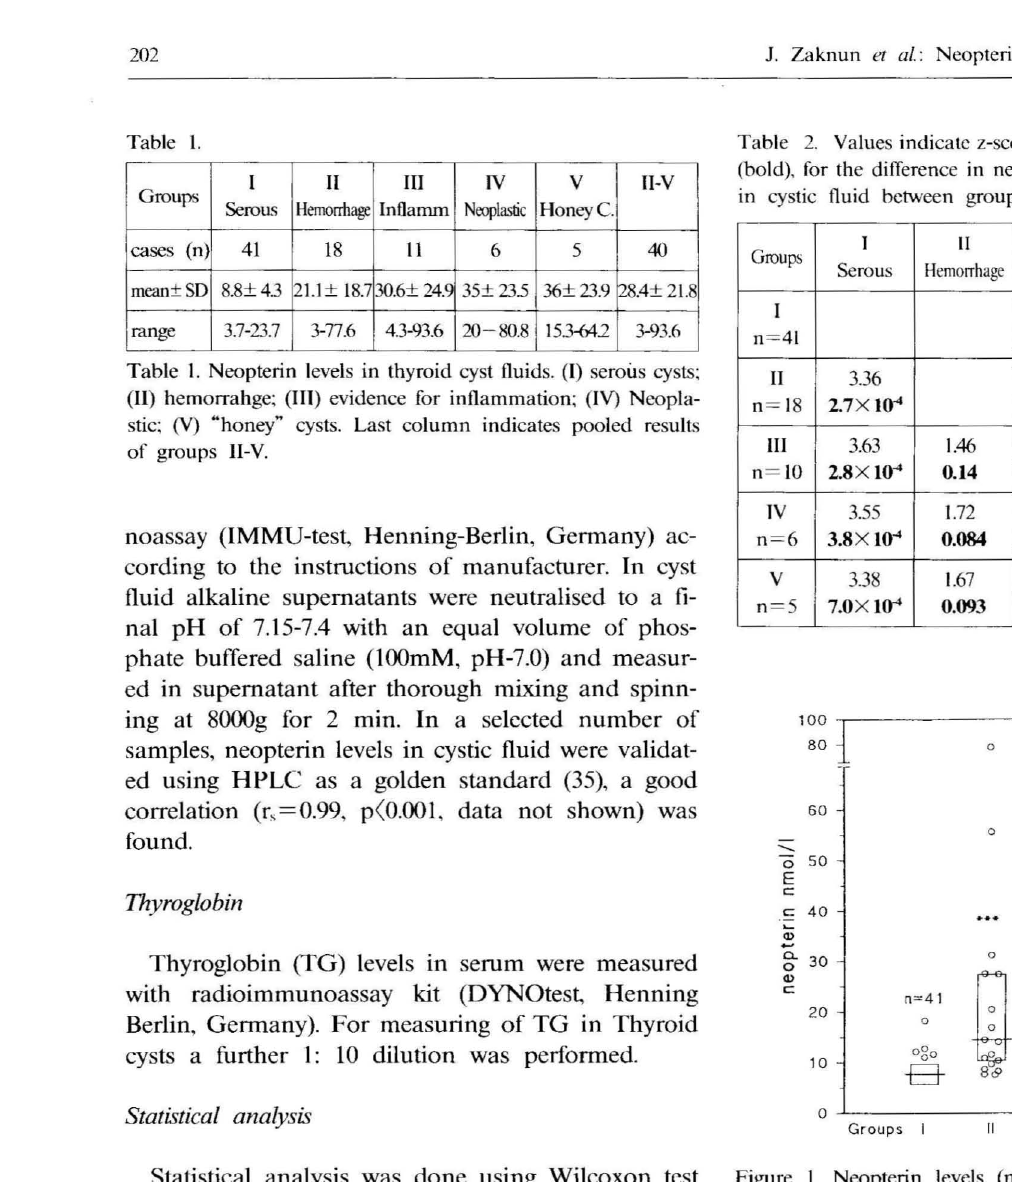
Table 2. Values indicate z-scores (plain) and significance level (bold), for the difference in neopterin concentrations measured in cystic fluid between groups. Wilcoxon test.